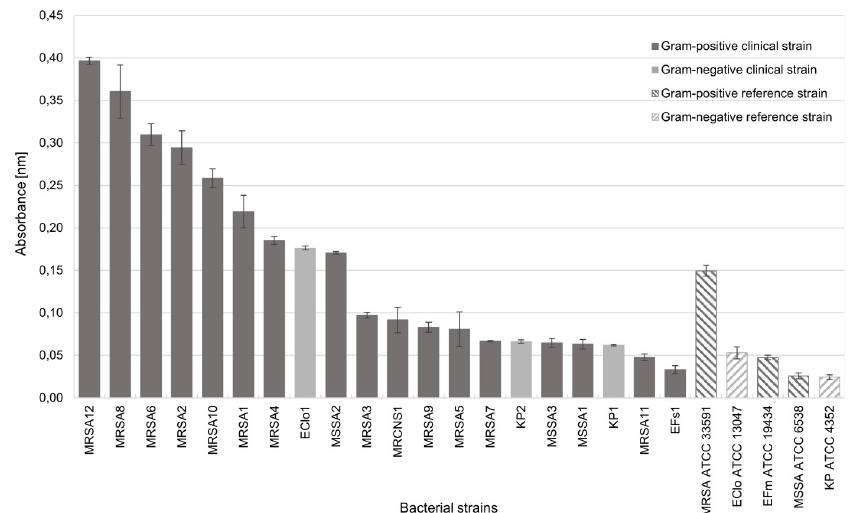
Fig 3. Biofilm forming ability on the surface of a polyurethane catheter. MRSA–methicillin-resistant Staphylococcus aureus , MSSA—methicillin-sensitive Staphylococcus aureus , MRCNS—methicillin-resistant coagulase-negative Staphylococcus hominis , EFs– Enterococcus faecalis , EFm– Enterococcus faecium , EClo– Enterobacter cloacae , KP– Klebsiella pneumoniae , ATCC–American Type Culture